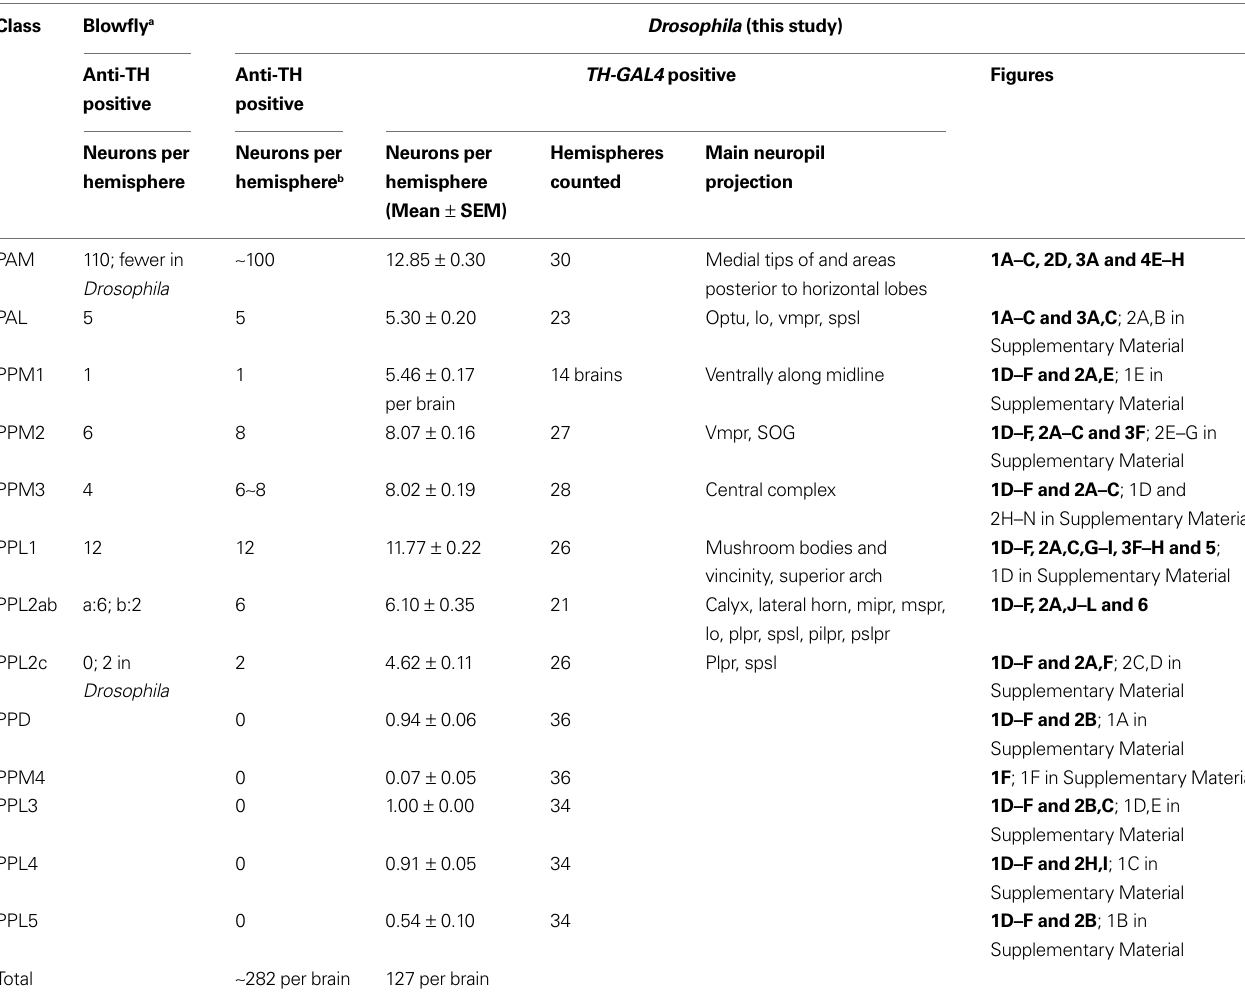
Table 1 | Classes of TH-GAL4 and anti-TH positive neurons in the